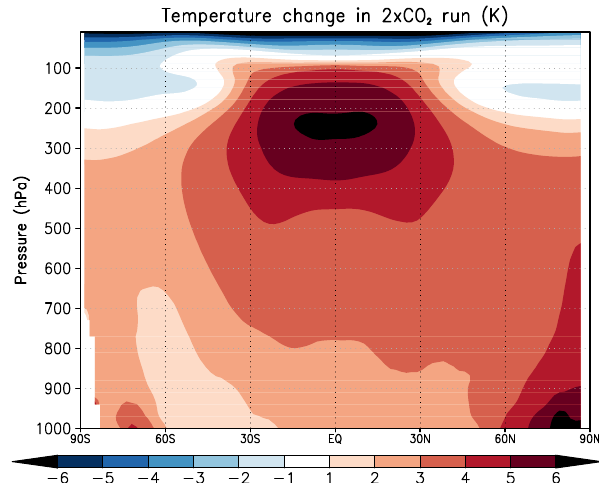
Fig. 2. Zonal-mean temperature change due to doubling of CO 2 concentrations in the coupled atmosphere-ocean ECHAM5/MPI- OM